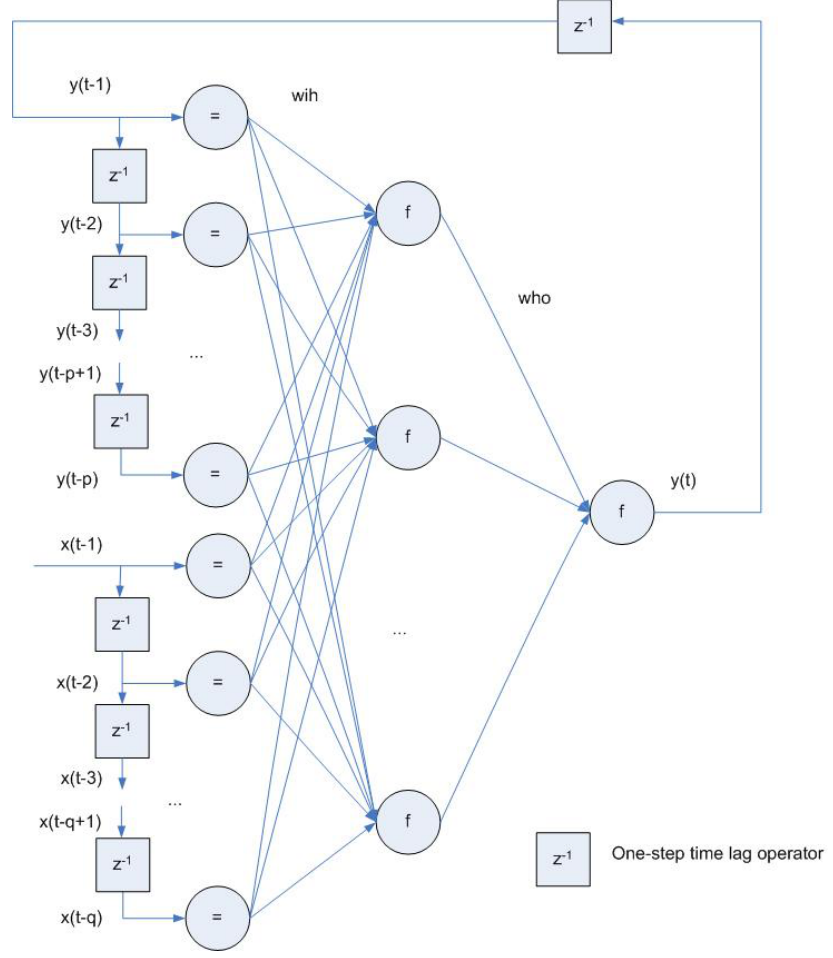
Figure 3. ERNN network